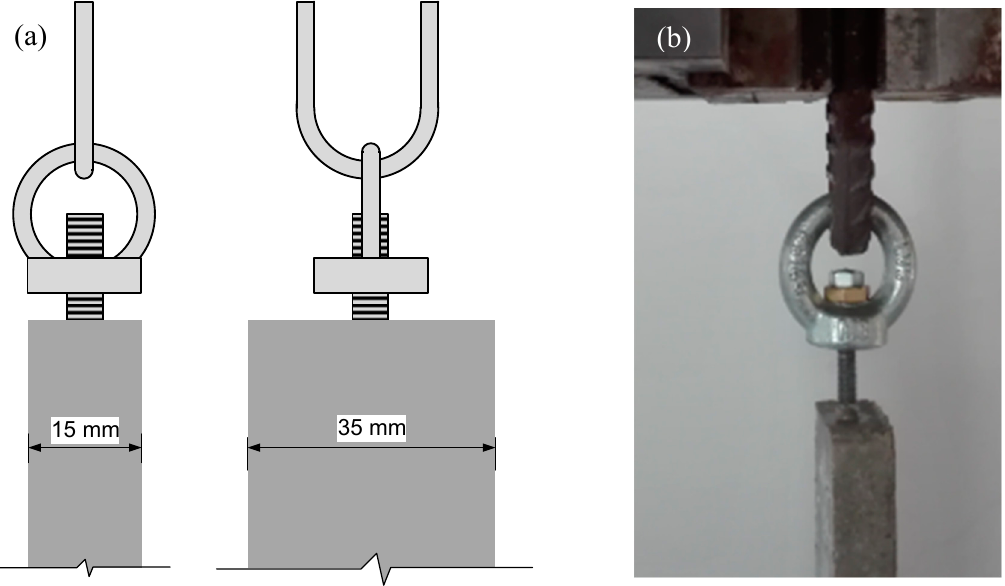
Figure 3. Sketch ( a ) and view ( b ) of the specimen-clamps connection.